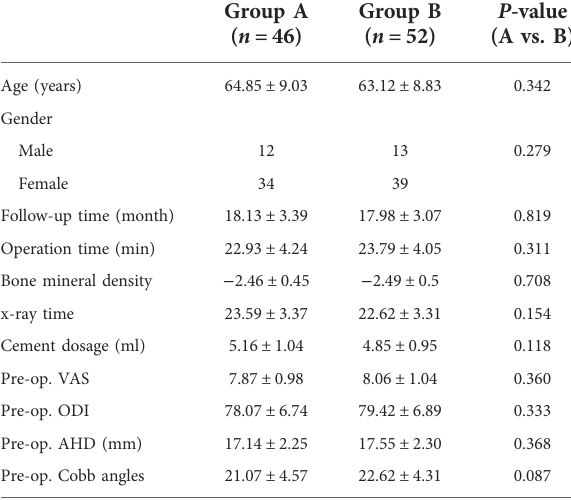
TABLE 1 Comparison of basic data and intraoperative related information.